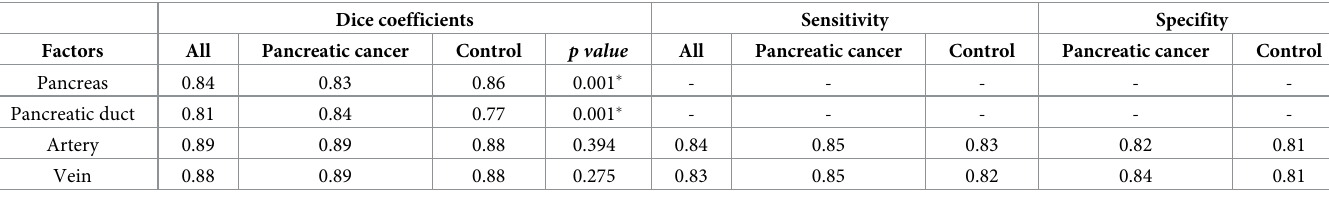
Table 2. Accuracy of the extracted 3D images including pancreas, pancreatic duct, artery, vein. Dice